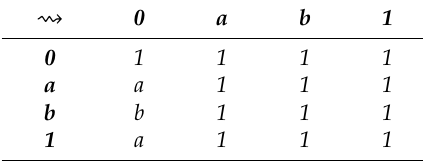
Table 5. The operation (cid:32) on X